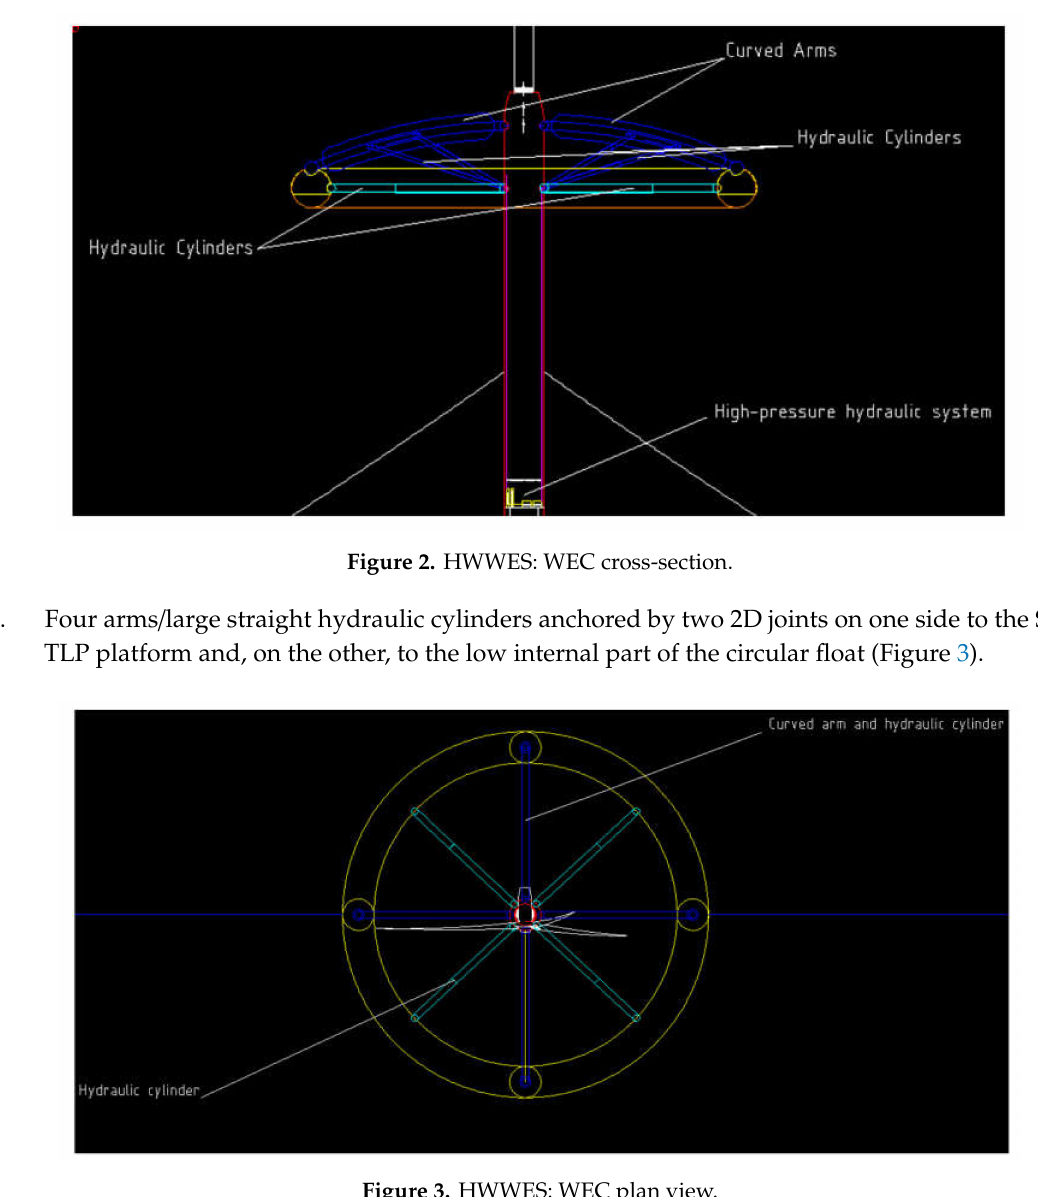
Figure 3. HWWES: WEC plan